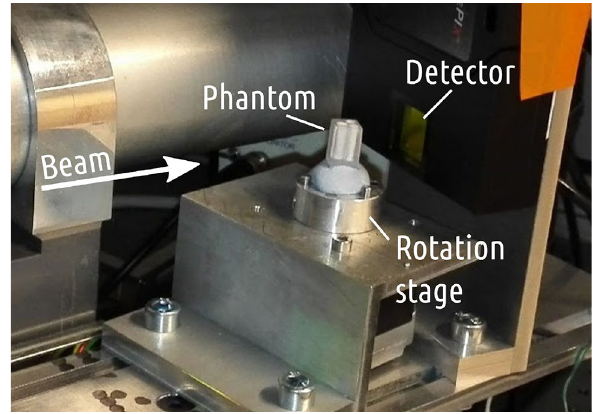
Figure 9. Photograph of the tomography setup. The detector in the picture is a different TimePIX-based model than the one used in this